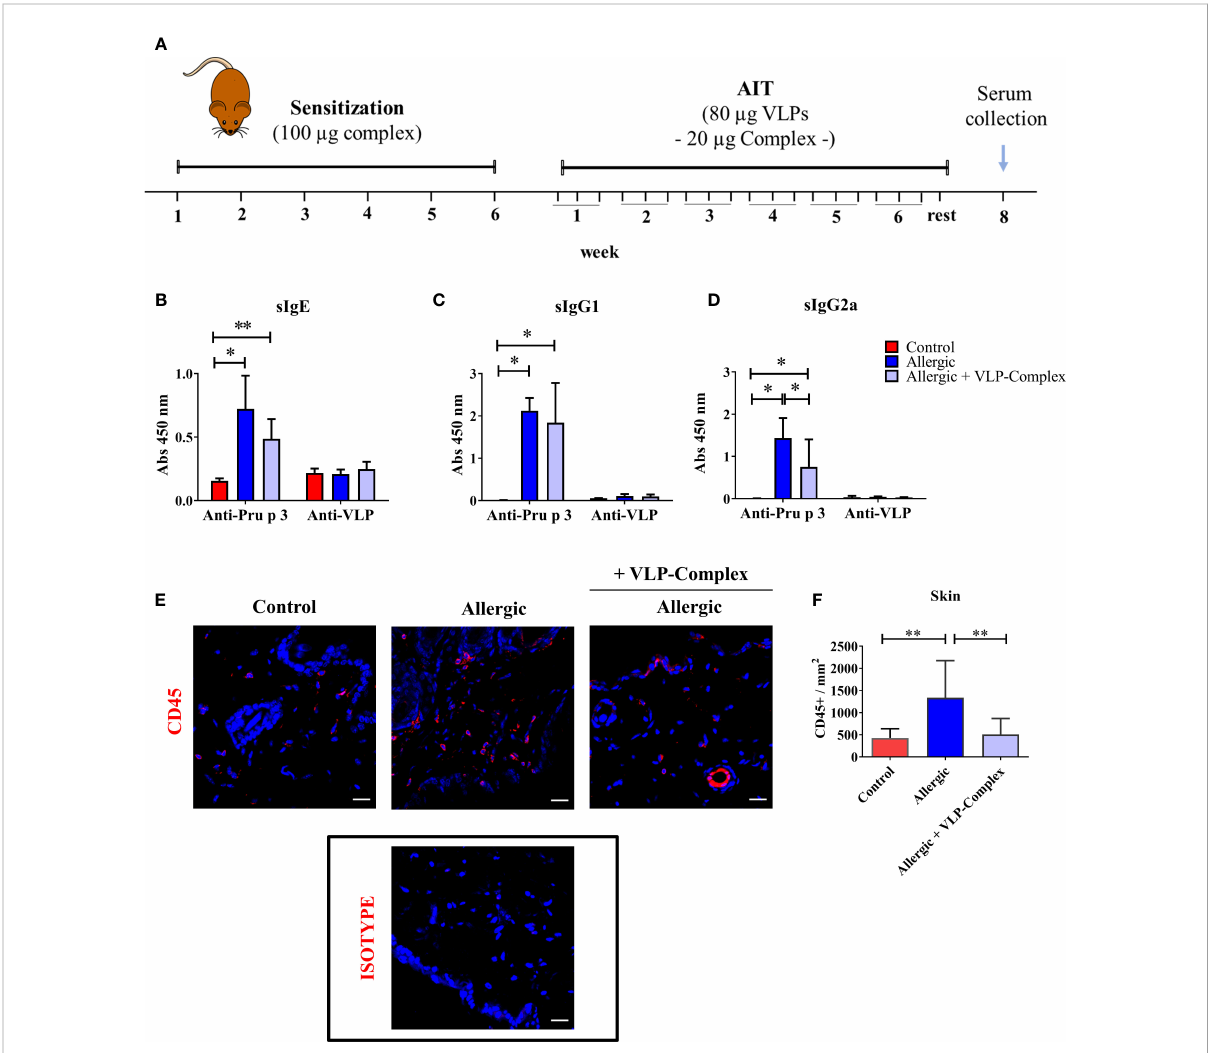
FIGURE 5 In vivo effectivity of VLP-Complex. (A) Schematic diagram showing the experimental procedures followed to sensitize and treat C3H mice (Control n = 5; Allergic n = 5; Allergic + VLP-Complex n = 9). Six consecutive weeks of sensitization were followed by six consecutive weeks of VLP-Complex sublingual treatment. After resting for one week, mice were euthanized by CO 2 suffocation and blood was collected by cardiac puncture. Levels of antigen speci fi c (Pru p 3 or VLP) (B) sIgE, (C) sIgG1, or (D) sIgG2a were assessed by ELISA. Each mouse was analyzed in triplicate. Data are presented as mean (SD, Mann-Whitney test). *P < 0.05, **P < 0.01. (E) Representative images and (F) quanti fi cation of skins and hybridized with anti-CD45 antibody (red). Nuclei (blue) stained with DAPI. 546-labelled anti-goat IgG was used as an isotype control. Quanti fi cation of CD45+ cell in fi ltration was calculated as the number of CD45+ per mm2 (n = 5/group; at least 3 sections were separately stained from each mouse at distal depths of the tissue and 3-5 images were taken per section). Data are presented as mean (SD. Mann-Whitney test). **P<0.01. Bar = 20